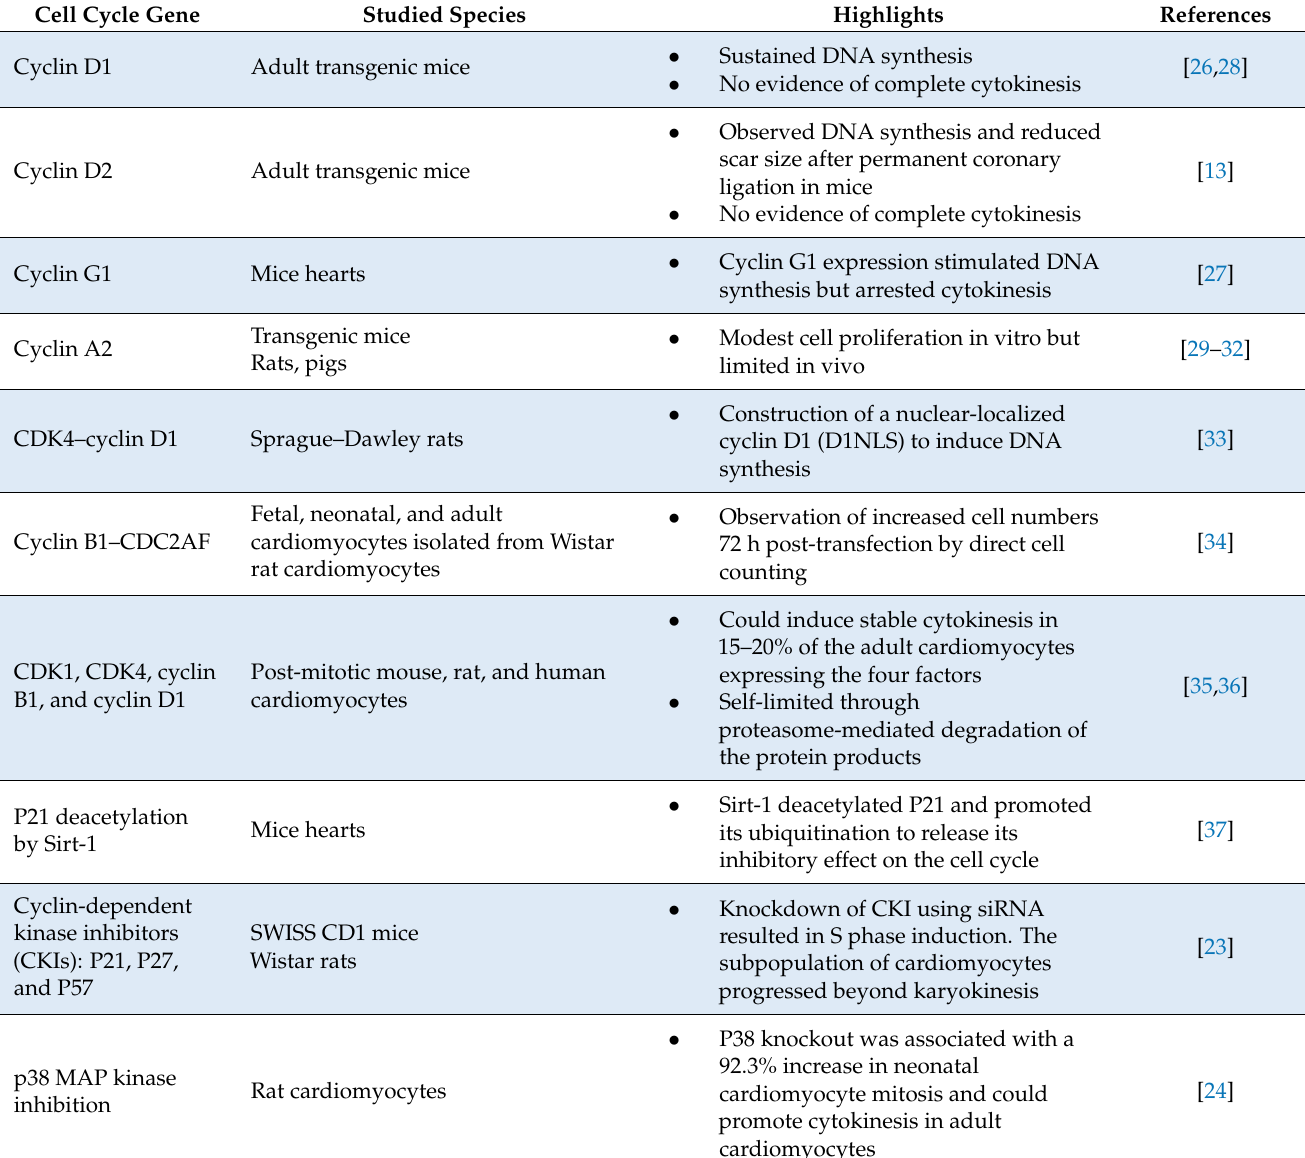
Table 1. Direct expression of cell cycle genes induces cardiomyocyte cell cycle entry. Cell Cycle